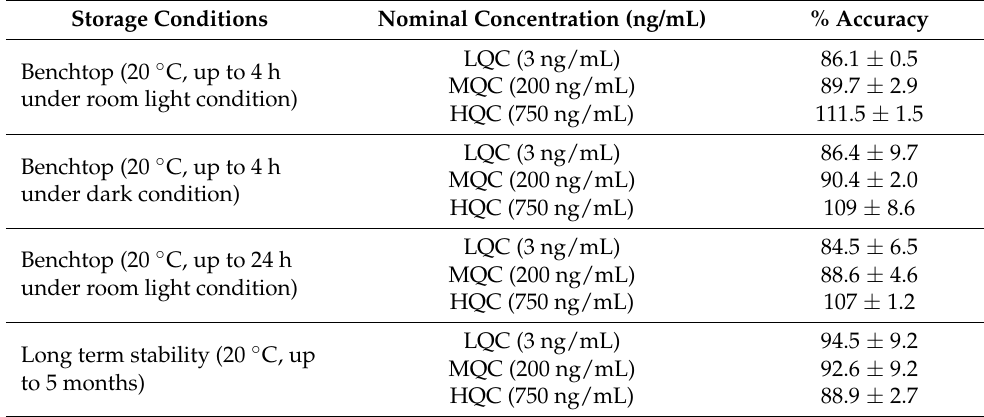
Table 4. Stability of ICG in stock solution under different laboratory storage conditions (mean ± SD, n =